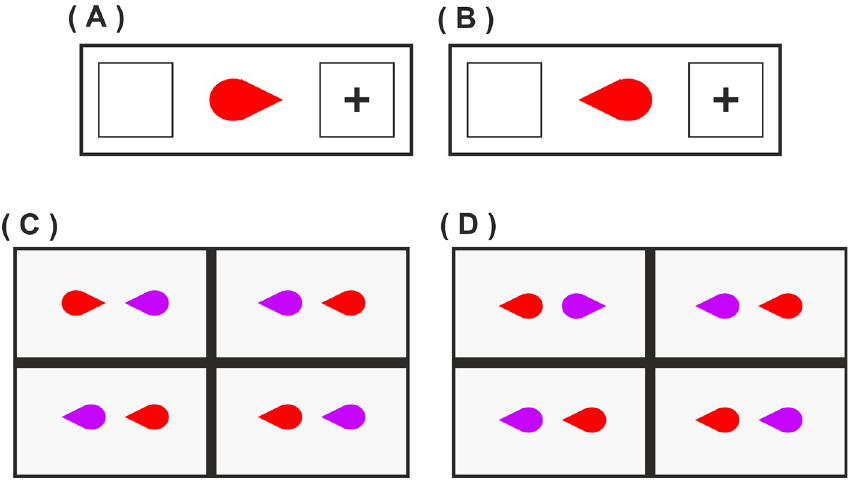
Fig 2. Examples of Posner cueing (A&B, Experiment 1) and visual search (C&D, Experiment 2, target pair in the top left quadrants) displays featuring stimuli with directional cues.